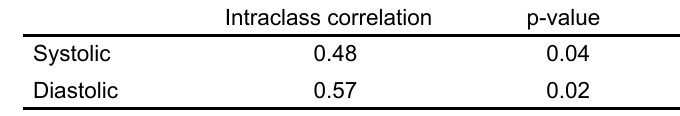
Table 2. Intraclass correlation between automated cuff and ultrasound-guided radial compression (URAC) systolic and diastolic blood pressure.